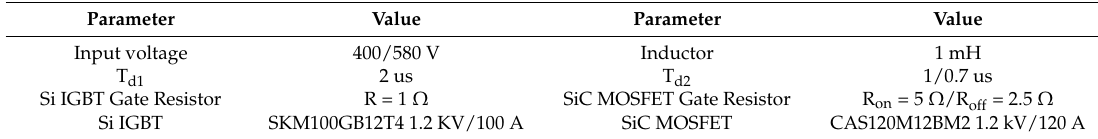
Table 1. The double pulse test for the hybrid switches parameters.